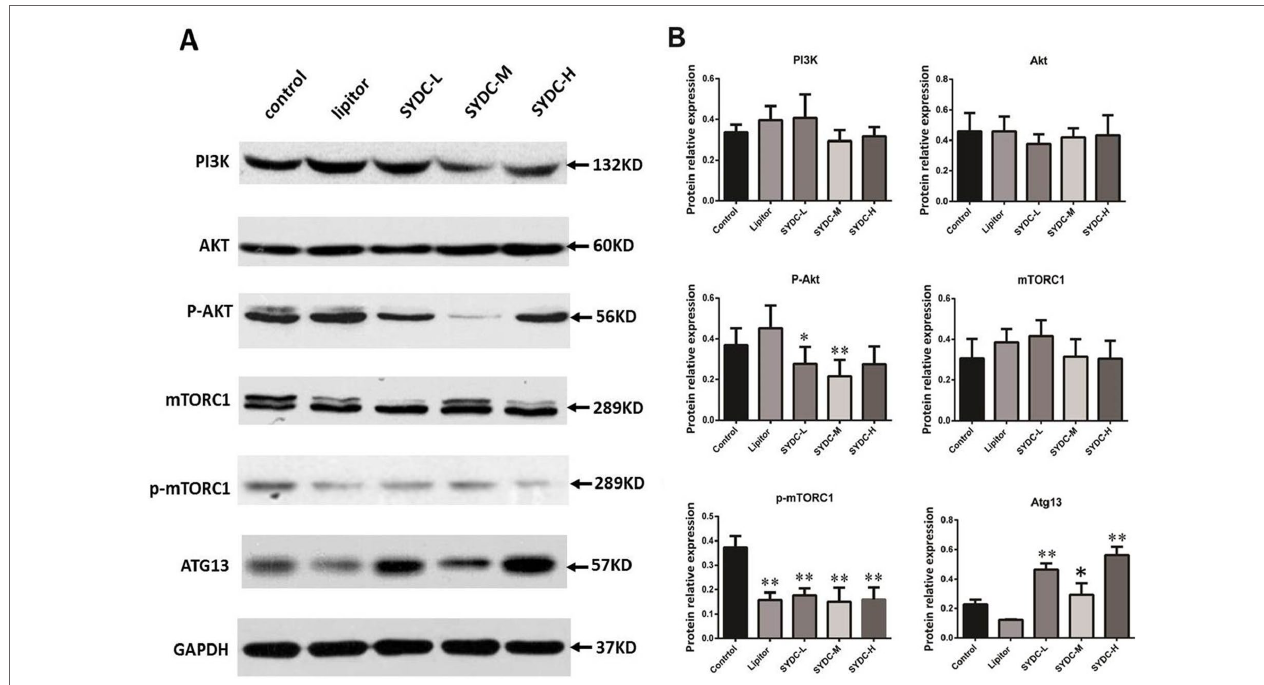
FIGURE 3 | Effect of SYDC on the phosphoinositide 3-kinase (PI3K)/Akt/mammalian target of rapamycin complex 1 (mTORC1)/Atg13 signaling pathway. (A) Representative images of Western blot showing PI3K, p-Akt, mTORC1, p-mTORC1, and Atg13 expression in the aortas of the control, Lipitor, SYDC-L, SYDC-M, and SYDC-H groups. GAPDH was used as a loading control. (B) Densitometry values of the Western blot analysis were normalized to GAPDH expression and represented as relative intensity (n = 5). * P < 0.05 vs. control group; ** P < 0.01 vs. control group.